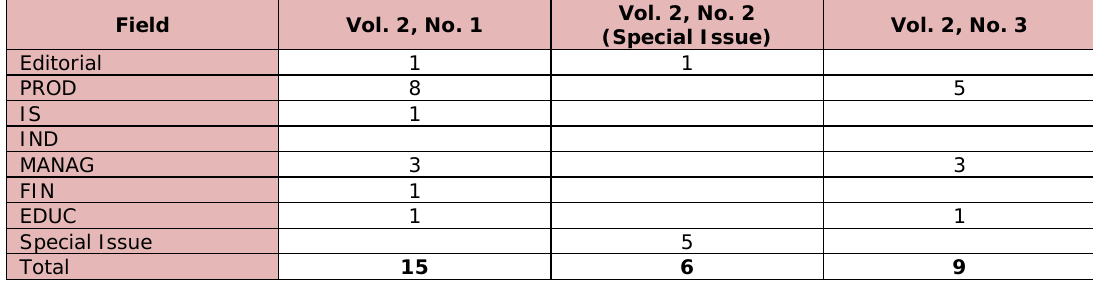
Table 1. “Items published in the Vol. 2 (2009) of JIEM, by field”. Source: Editors